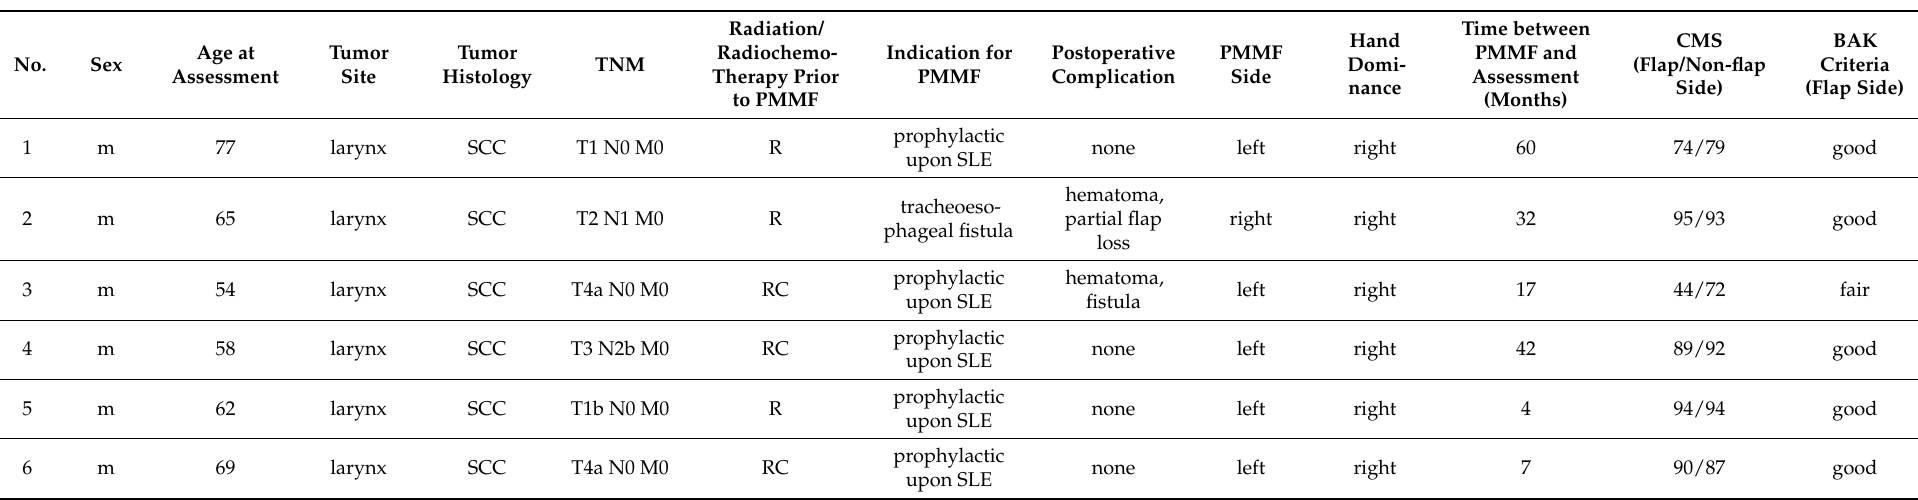
Table 3. Clinical